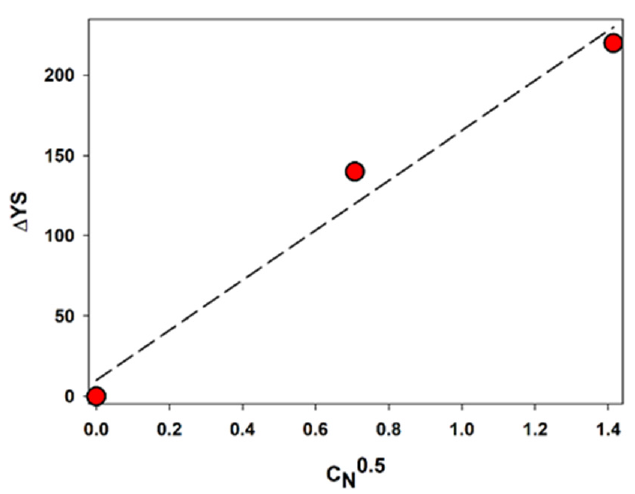
Figure 10. Relationship between the yield strength increase, ∆ YS, and N content, C N , in the program alloys at room temperature. Note that the dashed line is only a guide for eyes.